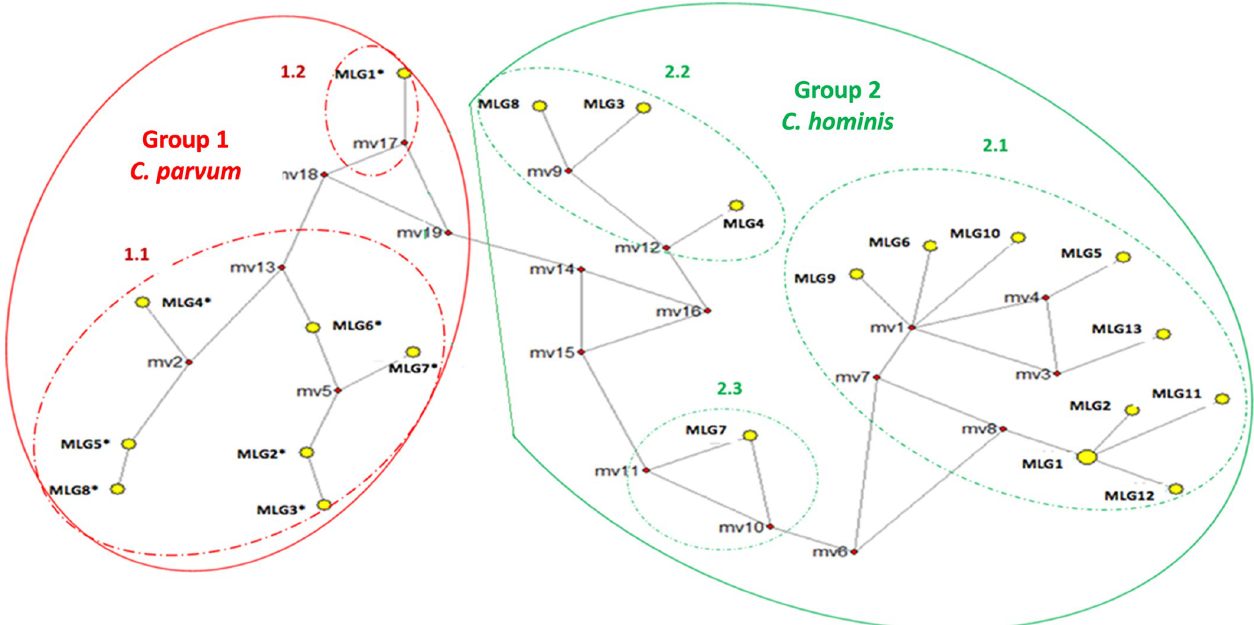
Fig 7. MLG Network constructed with the CS of the six markers for the C . hominis and C . parvum samples.